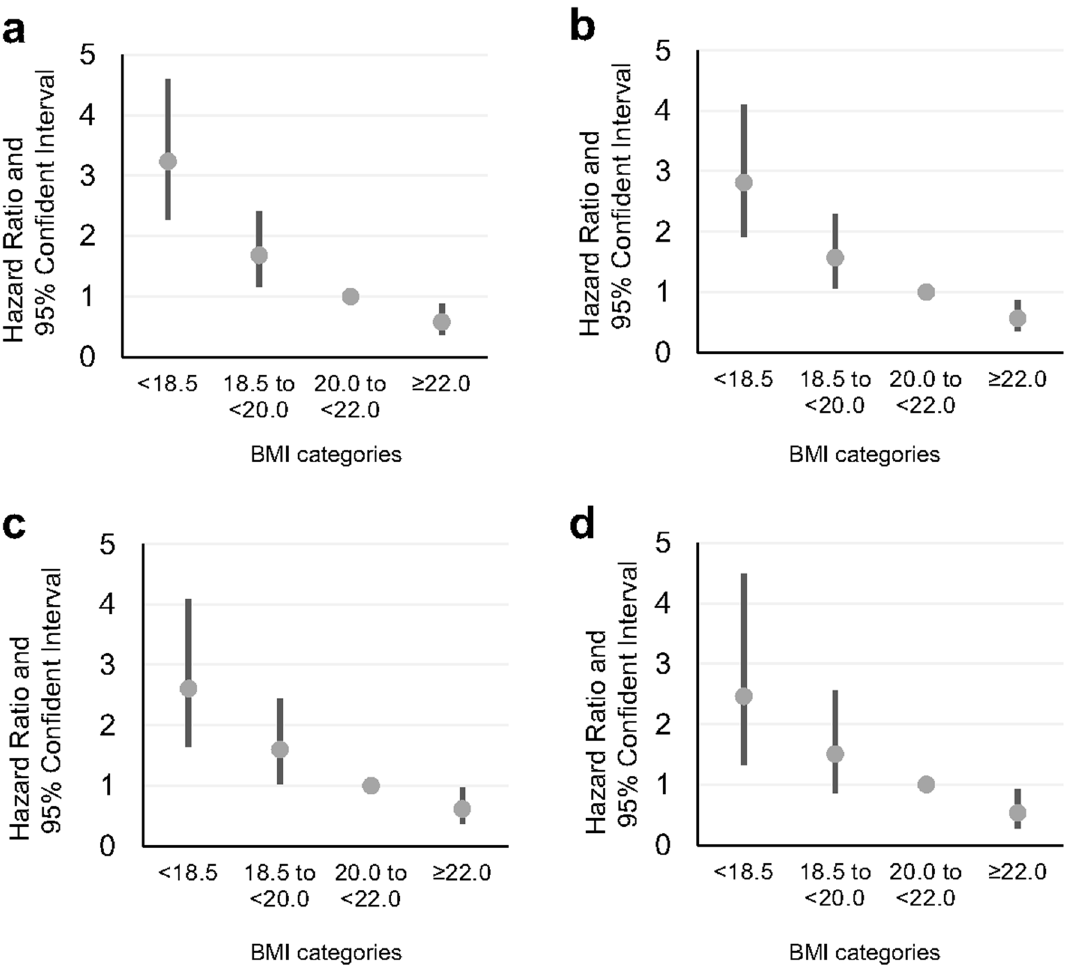
Figure 1. Hazard ratios (HR) and 95% confidence intervals (95% CI) of COPD mortality according to the four BMI categories. HR (95% CI) of the total population ( a ), and after excluding events within 5 years ( b ), 10 years ( c ) and 15 years ( d ), are